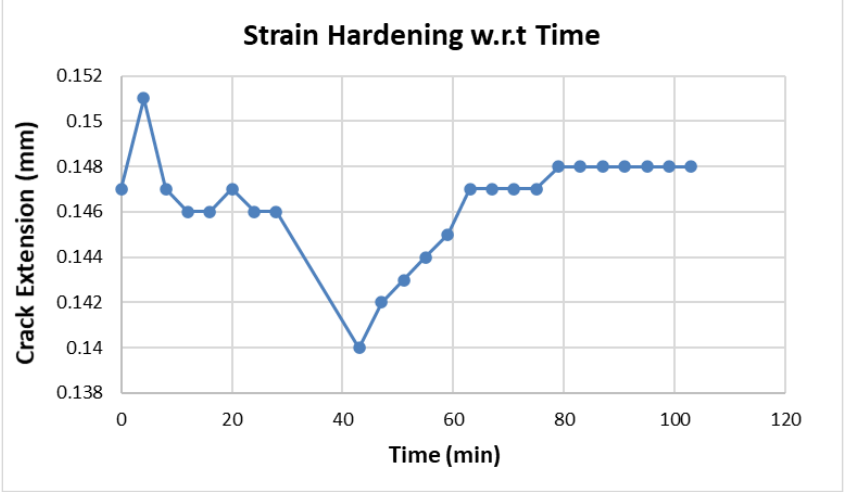
Figure 11. Strain hardening phenomenon with respect to time.